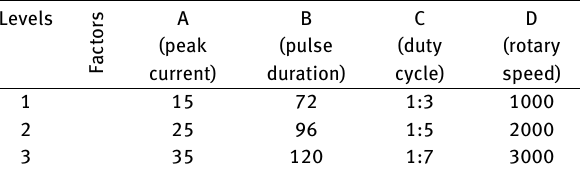
Table 4: Results of the orthogonal analysis on TWR of